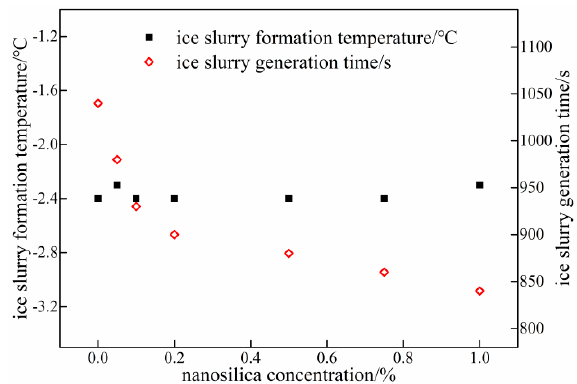
Figure 15. Ice slurry formation characteristics at different nanosilica concentrations.